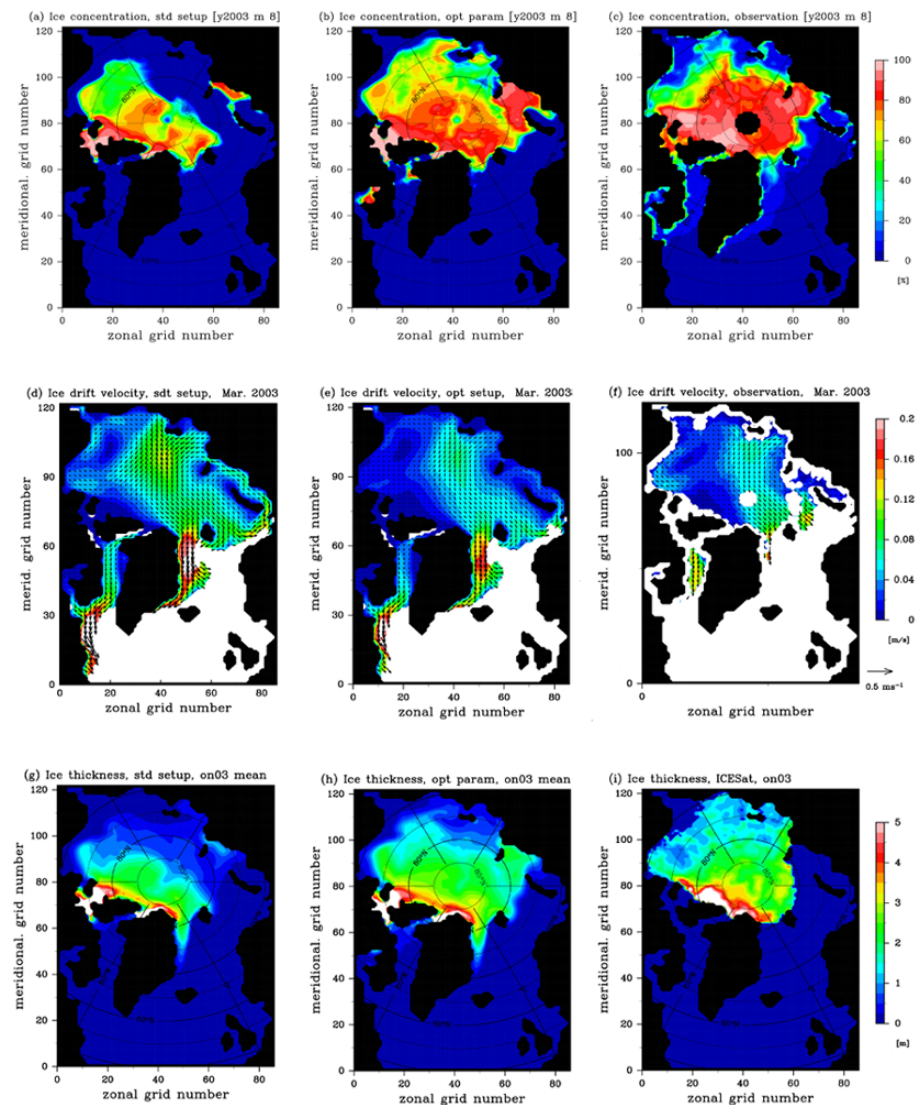
Fig. 8. Modeled and observed (a–c) monthly mean sea ice concentration in August 2003, (d–f) monthly mean ice drift velocity in March 2003 and (g–i) ice thickness in ON3 ICESat campaign period. The panels in the left column are NAOSIM with standard setup, while the panels in the center column are NAOSIM with the optimized parameter set obtained from the finite difference method with the standard-code, starting from the standard setup. The panels in the right column are from satellite observations: (c) OSI – 409, (f) OSI – 405 and (i)